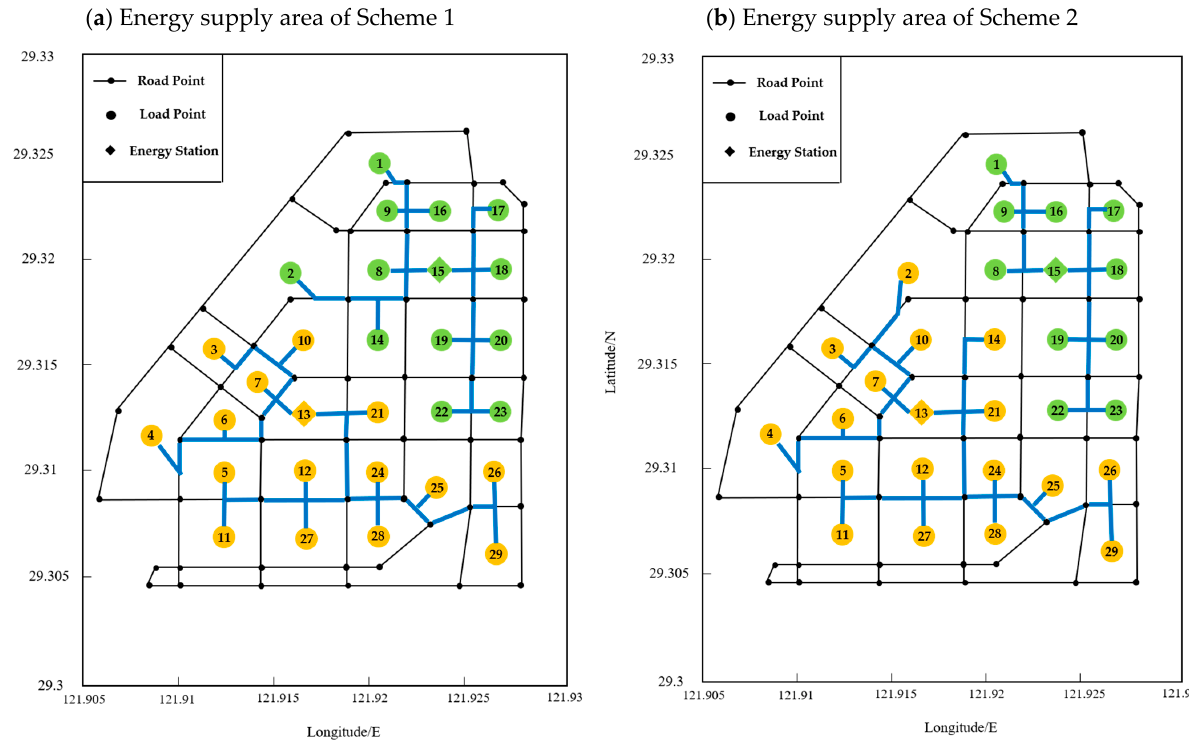
Figure 6. Comparison of two schemes. According to Figures 5 and 6, it can be observed that the load characteristics are con- sidered, that is, adopting relative-load-distance, so that the load points (load 2 and load 4) are no longer supplied by the nearest energy station (Station 15), but belong to the energy station (Station 13) relatively far away from it. Therefore, the annual conversion cost of